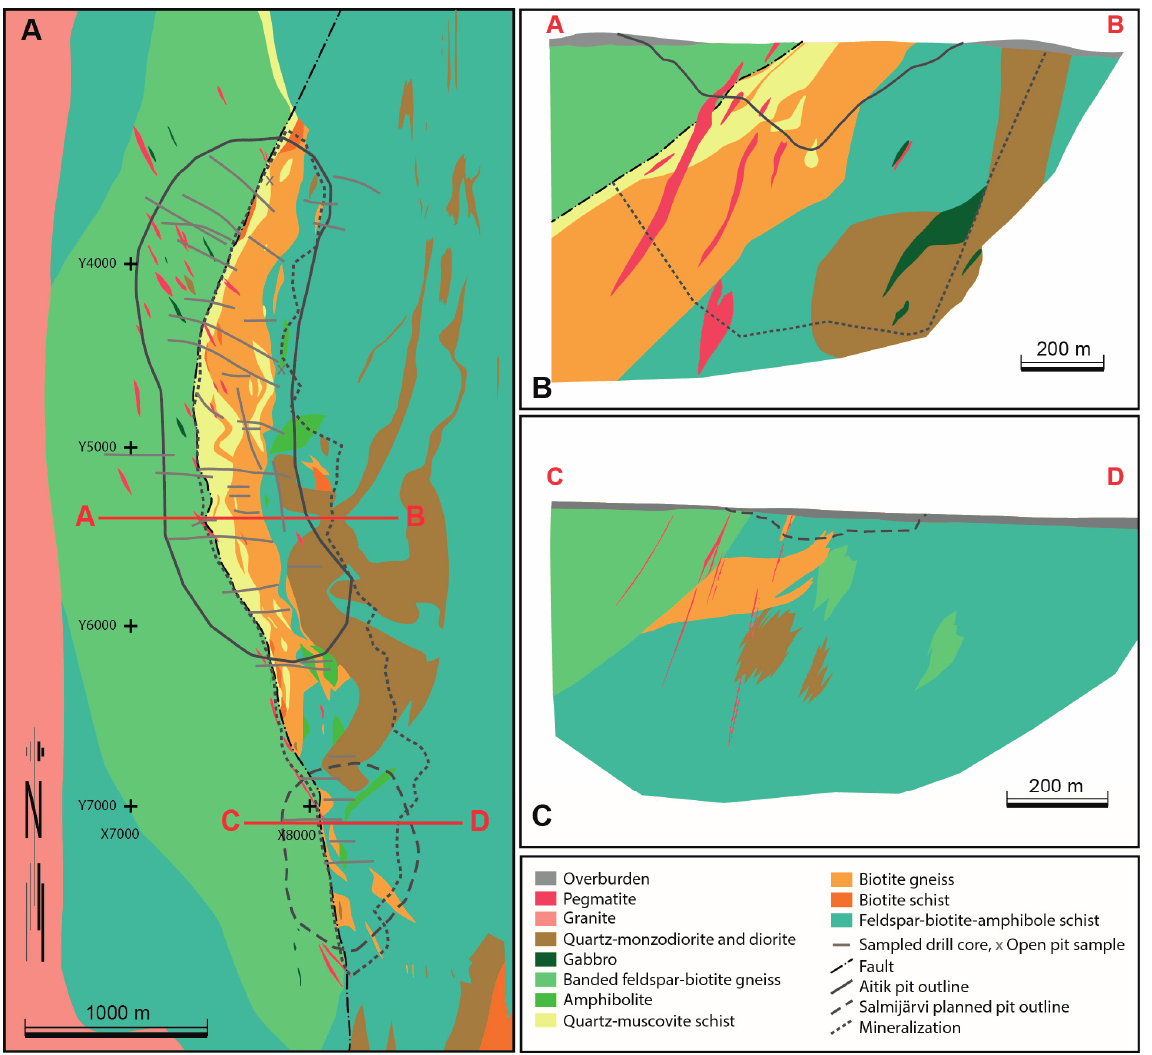
Figure 2. Geology and open pit contours of the Aitik and Salmijärvi deposits and their close surroundings. Local coordinates in meter; ( a ) Horizontal section at 100–200 m depth; ( b ) Schematic E-W vertical section of the Aitik deposit; ( c ) Schematic E-W vertical section of the Salmijärvi deposit. Modified from